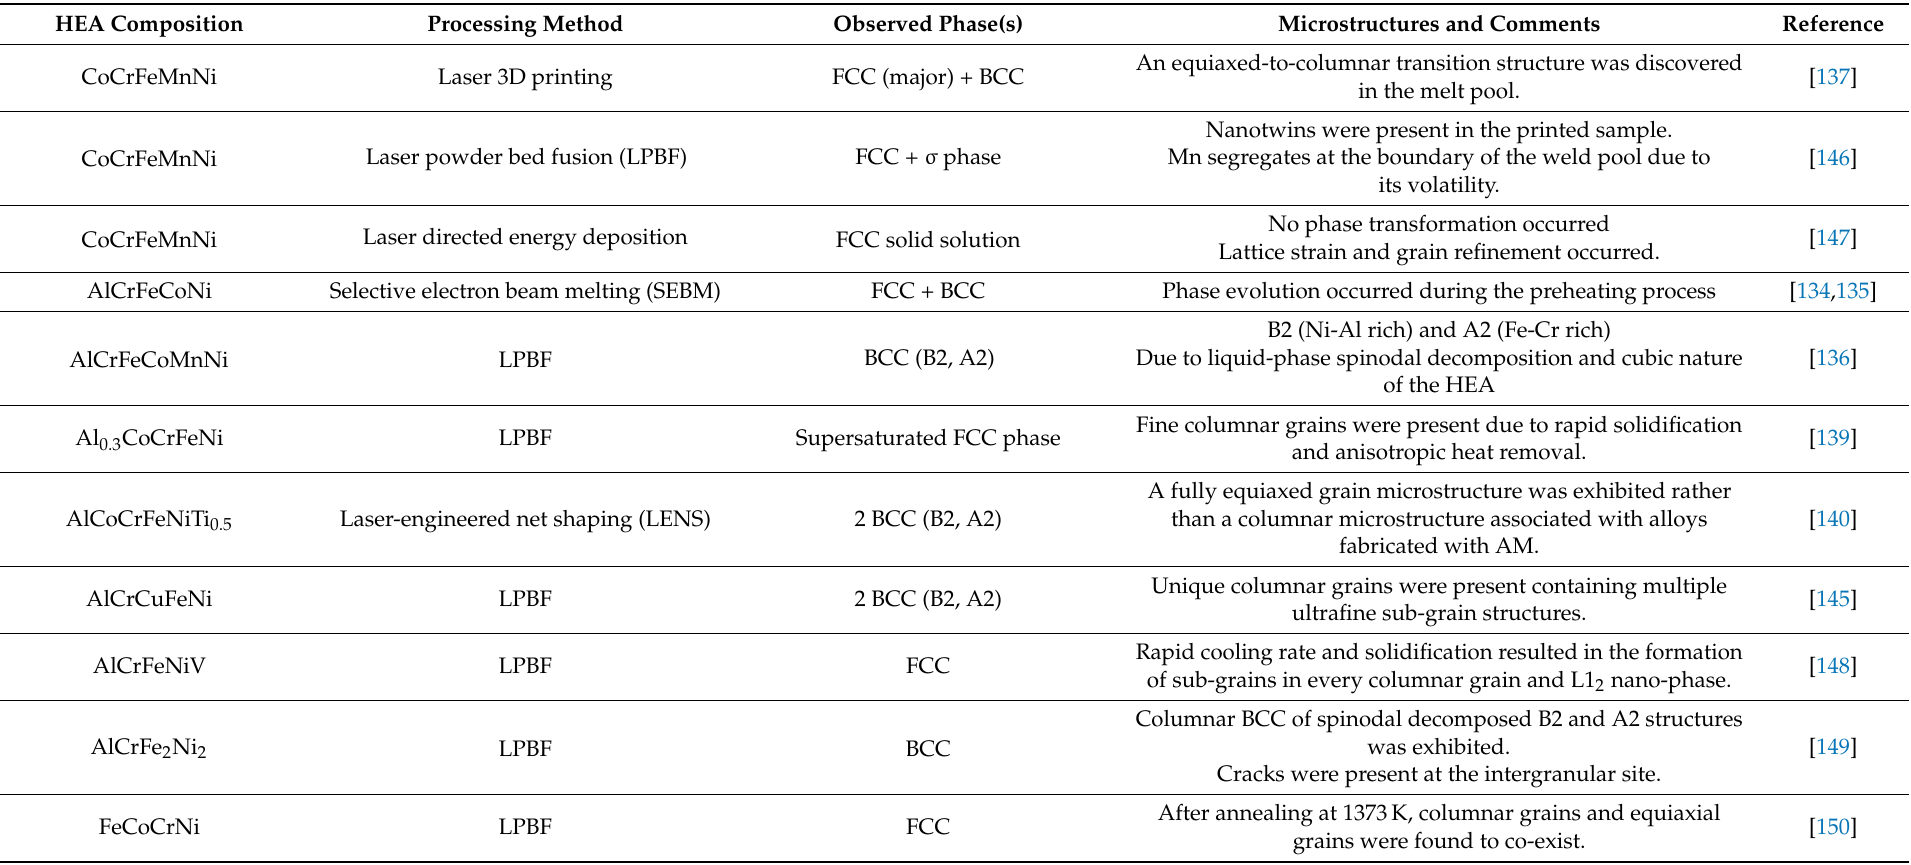
Table 3. Phase evolution of HEAs fabricated using different additive manufacturing